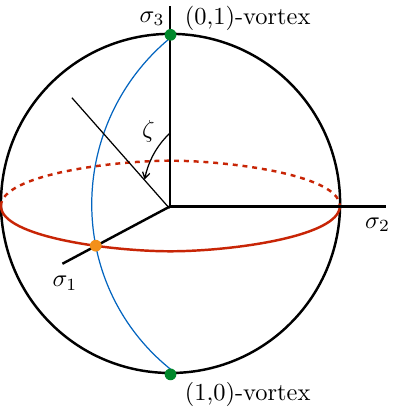
Figure 4 . The moduli space S 2 of a non-Abelian vortex